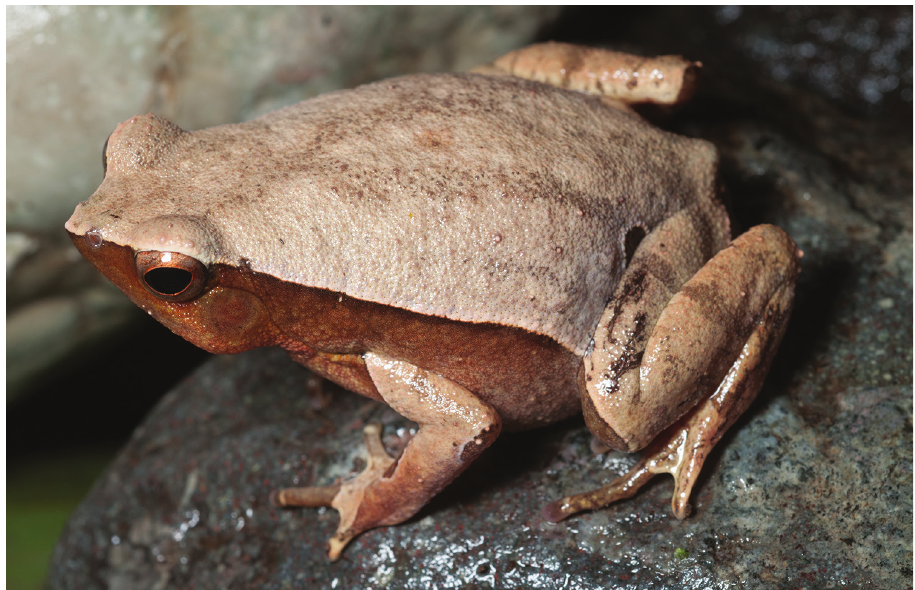
Figure 20. Kalophrynus sinensis male (KU 333148) from Mt. Hilong-hilong Municipality of